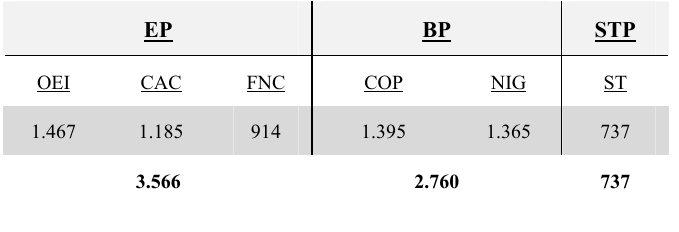
Table I: Number of tokens by varieties of Portuguese EP BP